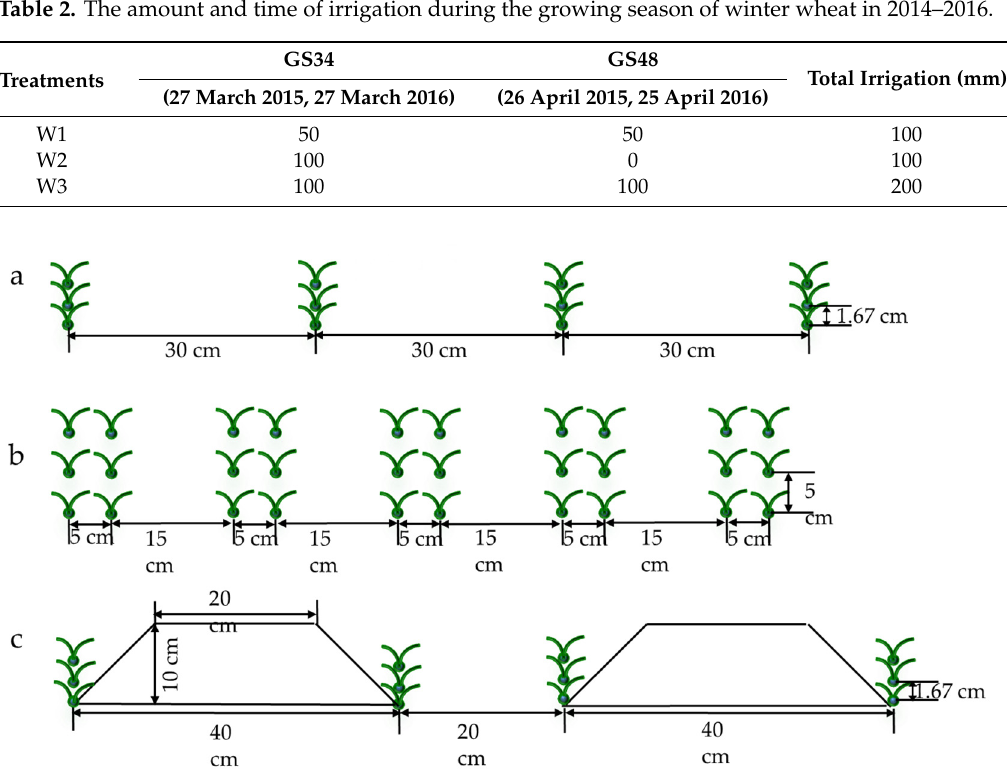
Table 1. Description of growth stage scales.